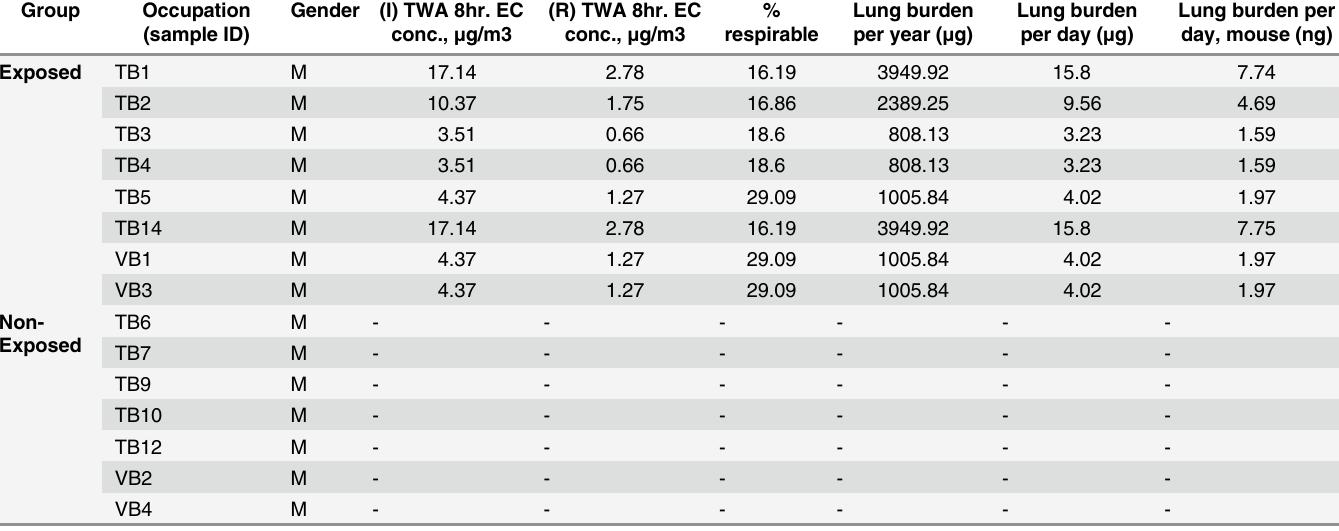
The 8hr time-weighted average (TWA) EC concentrations for each occupation in the exposed group were calculated based on inhalable/respirable EC concentrations of PBZ samples (see Table 1) as well as time spent by the personnel in that particular unit/technological process during a working